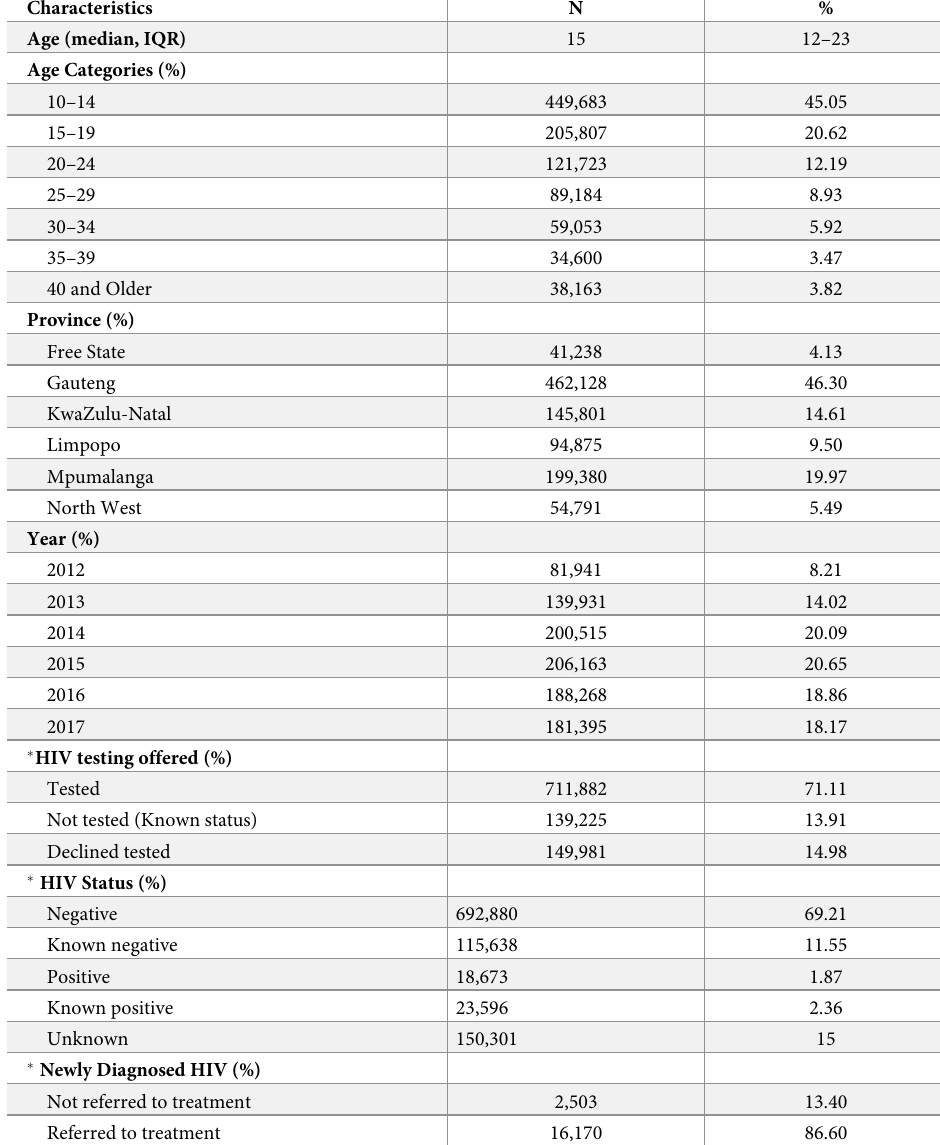
Table 1. Description of participants characteristics.